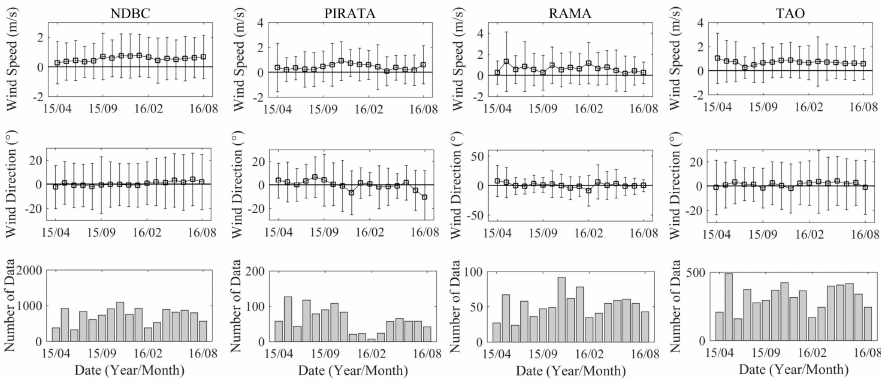
Figure 6. Errors of RapidScat wind vectors in different months from April 2015 to August 2016 for NDBC, PIRATA, RAMA, and TAO